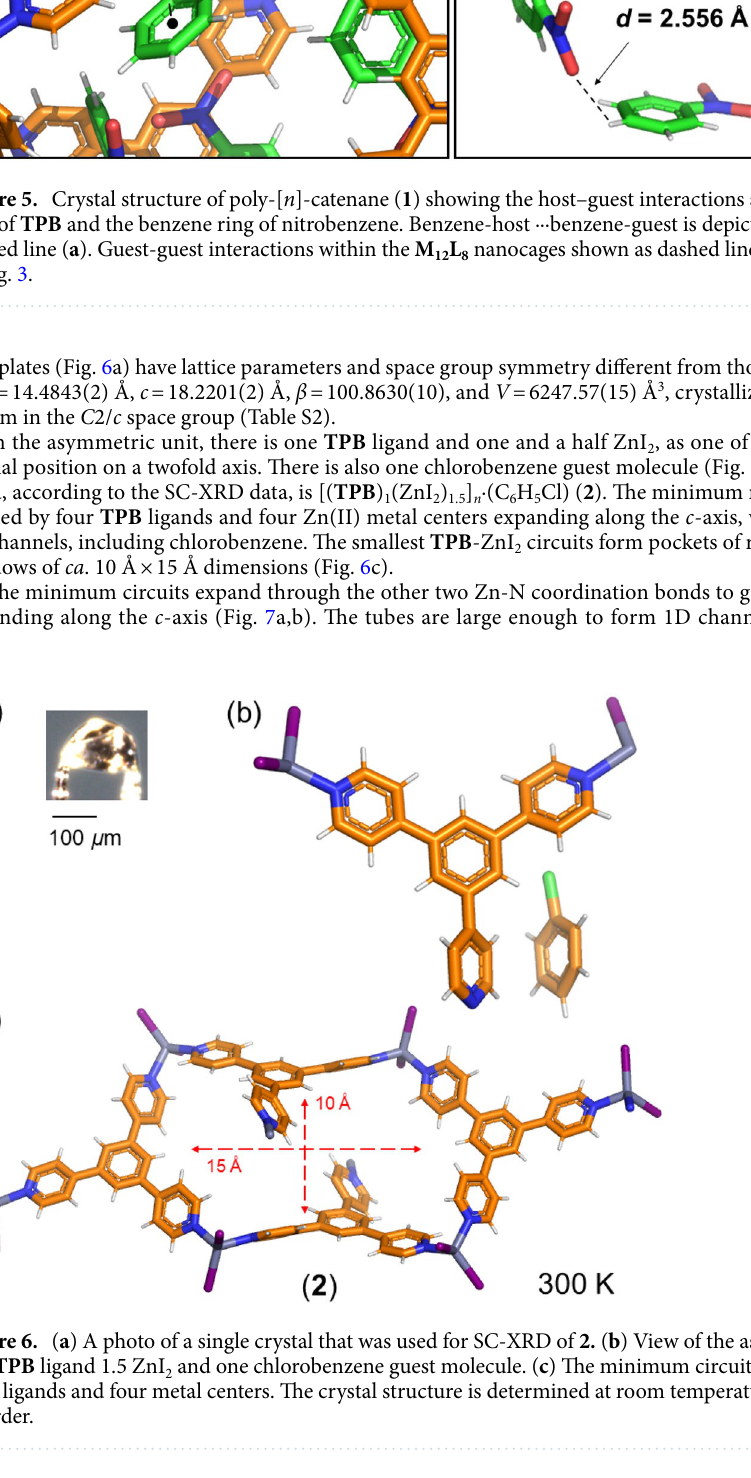
Figure 6. ( a ) A photo of a single crystal that was used for SC-XRD of 2. ( b ) View of the asymmetric unit with one TPB ligand 1.5 ZnI 2 and one chlorobenzene guest molecule. ( c ) The minimum circuits are formed of four TPB ligands and four metal centers. The crystal structure is determined at room temperature and does not show